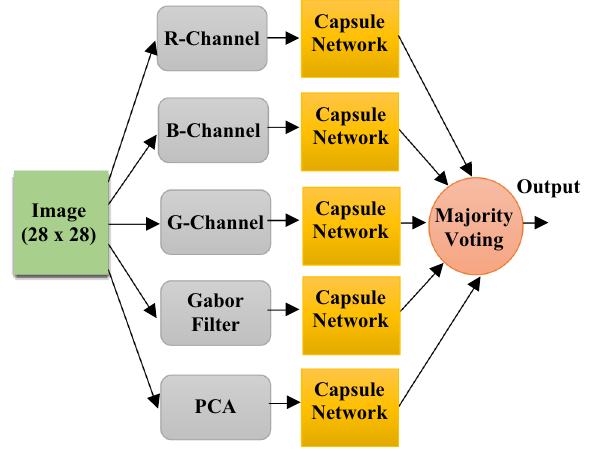
Fig. 2 The pipeline of the proposed